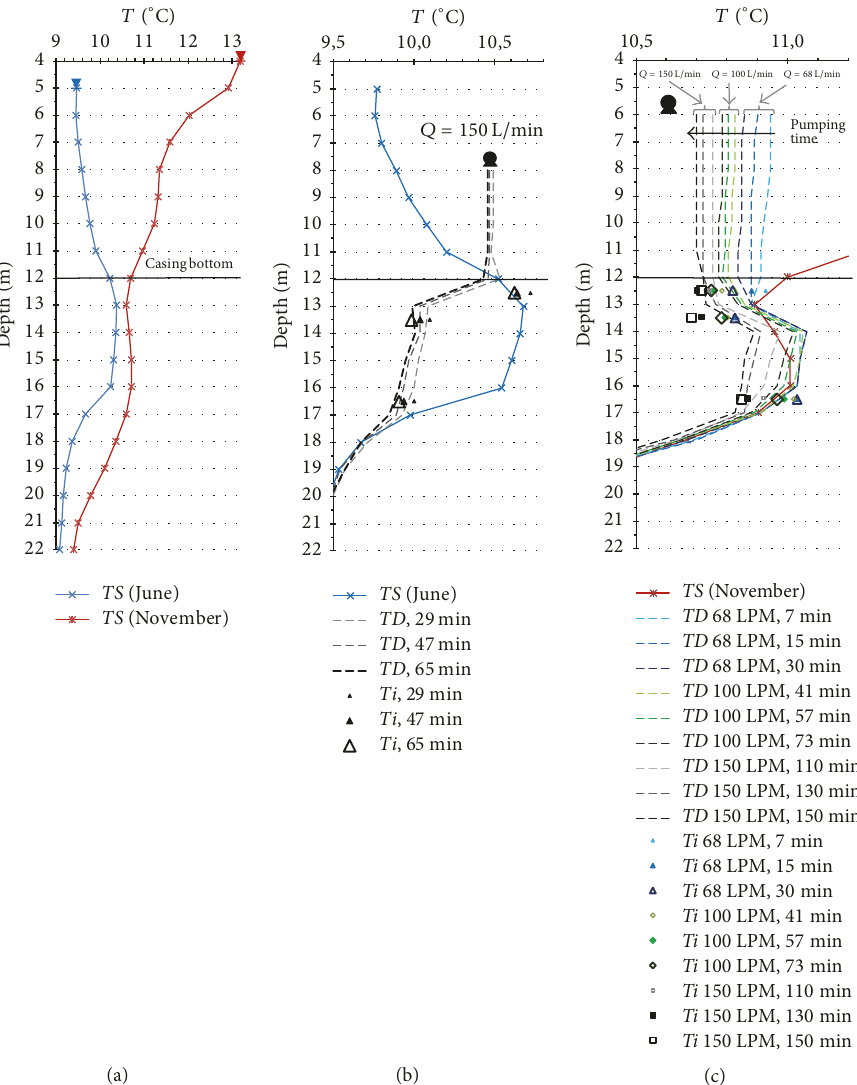
Figure 12: Temperature profiles in well F3: static conditions for June and November 2016 (a); static and dynamic conditions with several discharge rates and pumping durations for June (b) and November (c). 𝑇 𝑖 are the mean inflow temperatures calculated using the borehole- scale heat